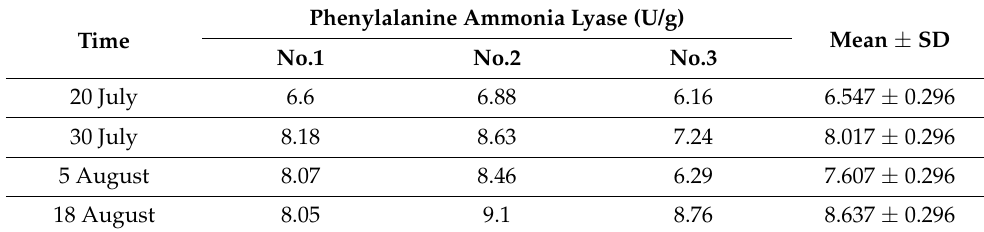
Figure 4. Changes in phenylalanine ammonia lyase in host leaves at different times of injury.